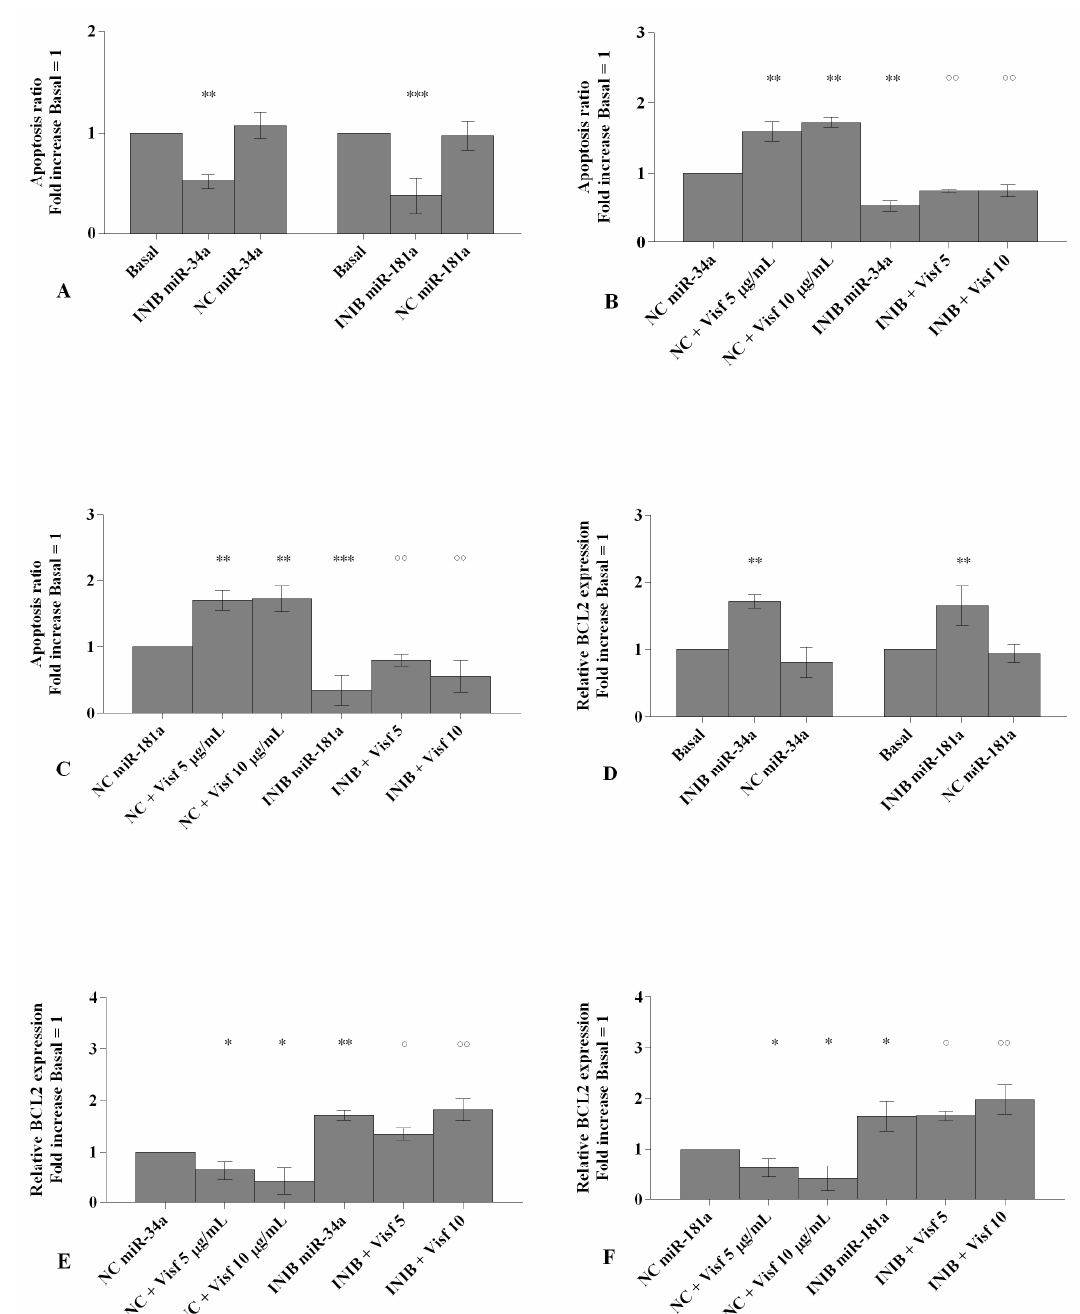
Figure 3. ( A – C ) Detection of apoptosis by flow cytometry analysis. Apoptosis was measured with Annexin Alexa fluor 488 assay. Data were expressed as percentage of positive cells for Annexin-V and propidium iodide (PI) in all the studied conditions. ( D – F ) Expression levels of B-cell lymphoma (BCL2) by real-time PCR. Human osteoarthritic (OA) chondrocytes were evaluated at basal condition, after 24 h of transfection with miR-34a and miR-181a inhibitors (50 nM) or NC (5 nM) and after 24 h of stimulus with visfatin (5 μ g/mL and 10 μ g/mL). The ratio of apoptosis and the gene expression were referenced to the ratio of the value of interest and basal condition (Basal, cells without treatment) or NC. The value of basal condition or NC were reported equal to 1. Data were expressed as mean ± SD of triplicate values. * p < 0.05, ** p < 0.01, *** p < 0.001 versus basal condition or NC. ° p < 0.05, °° p < 0.01 versus inhibitor. INIB = Inhibitor, NC = negative control siRNA, Visf = Visfatin.